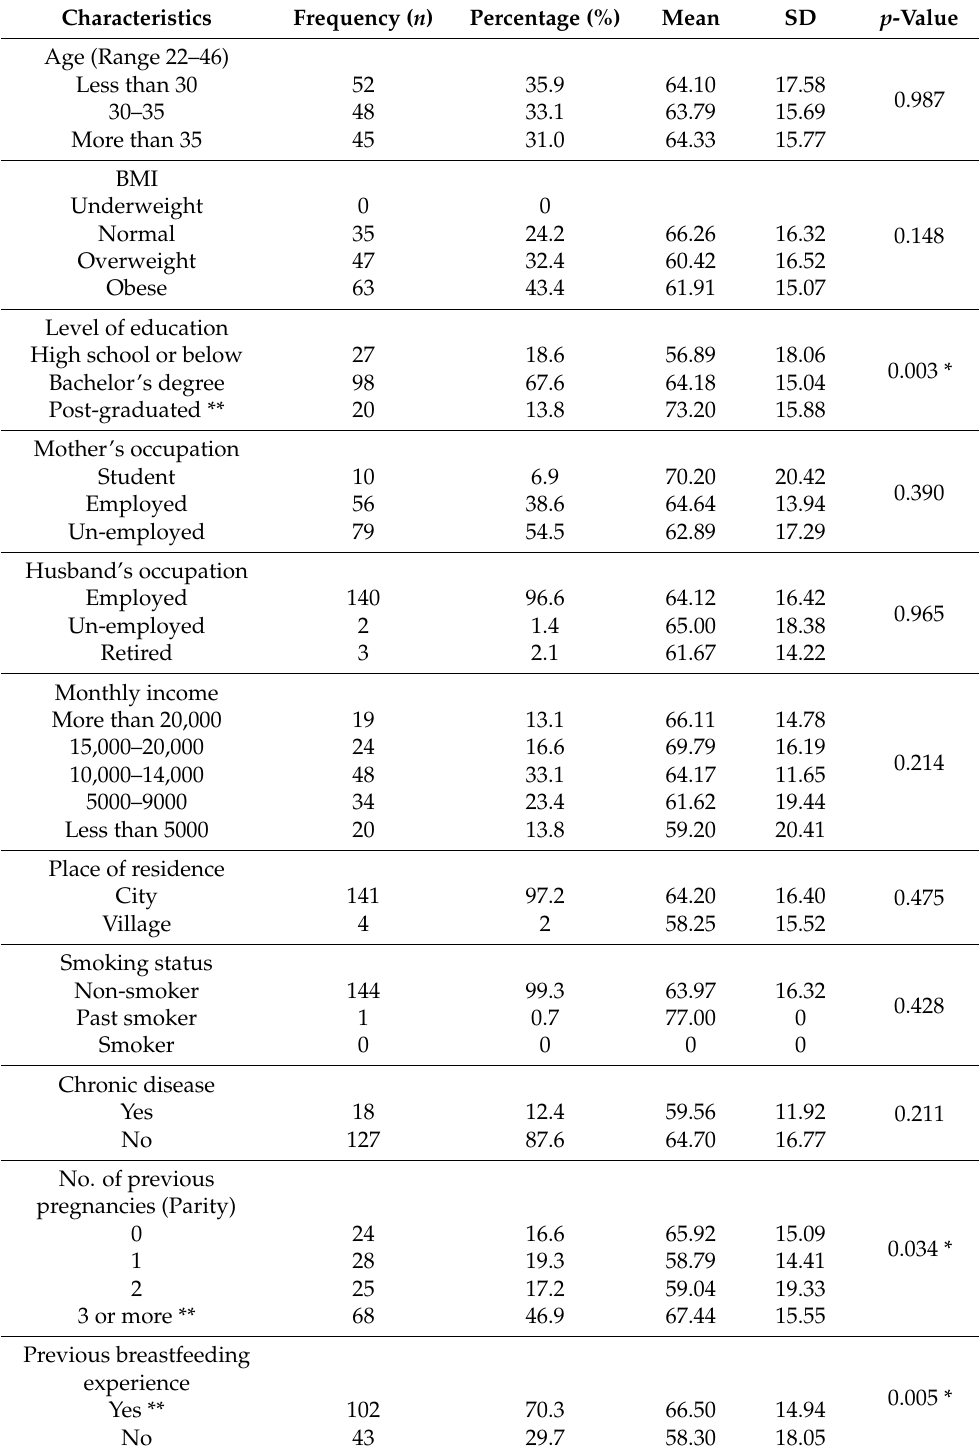
Table 1. The socio-demographic characteristics of the participants and its correlation with the total prenatal breastfeeding self-efficacy score ( n =